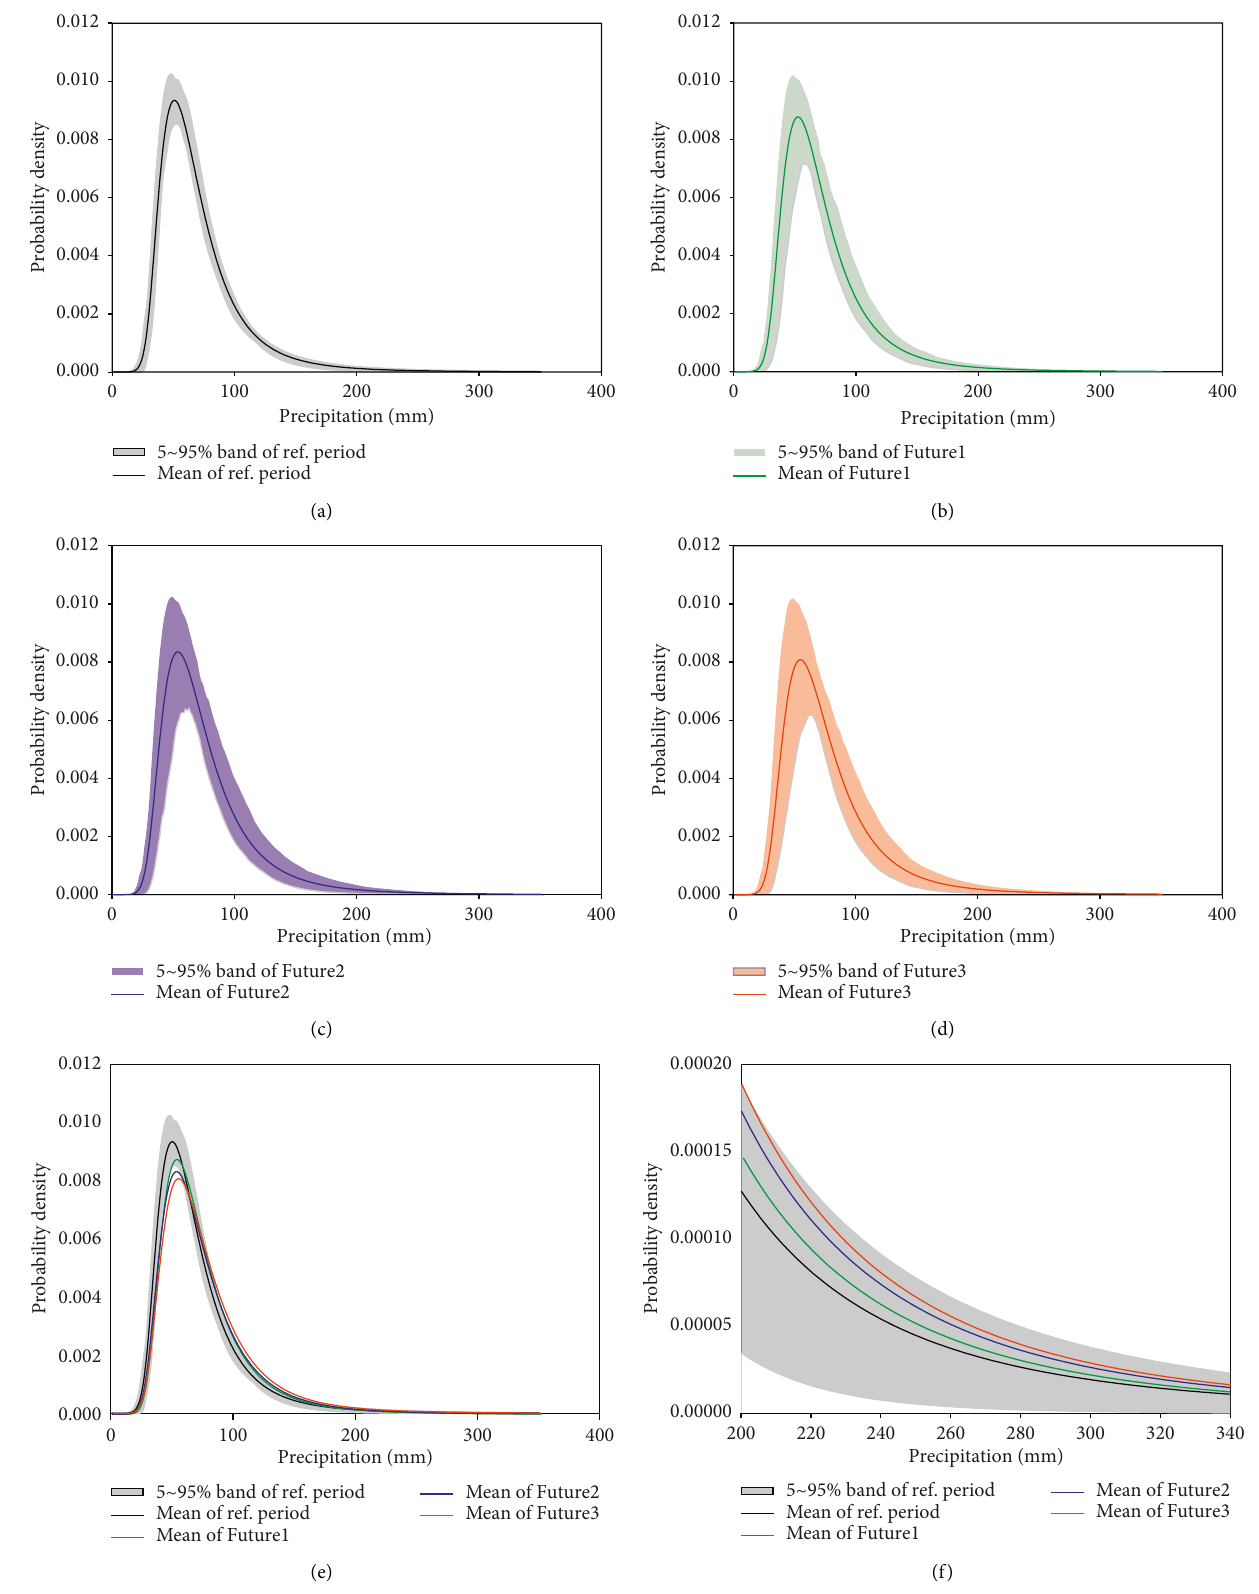
Figure 6: GEV probability density functions considering all downscaling methods for (a) reference, (b) Future1, (c) Future2, (d) Future3 period, (e) all together, and (f) zoomed Figure 6(e) for extreme